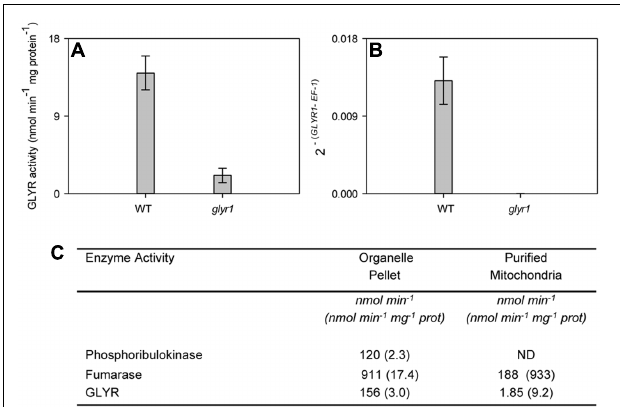
FIGURE 5 | Mitochondrial localization of GLYR2 activity in rosette leaf tissue from Arabidopsis. Total GLYR activity (A) and GLYR1 expression (B) in WT and glyr1 knockout mutant. Data represent the mean ± SE of three biological replicates. GLYR activity (total per fraction, or protein bases) in the organelle suspension and purified mitochondria from glyr1 mutant (C) . Data represent a preparation of 50 g of rosette leaf tissue; ND, not detected. Similar results were obtained with a replicate